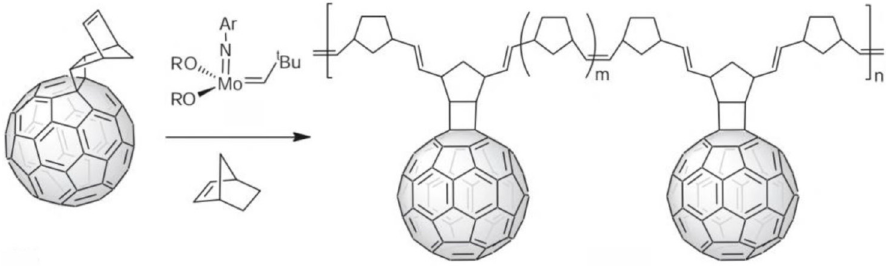
Figure 3. Polymerisation of norbornene-modified C 60 using ring-opening metathesis polymerisation